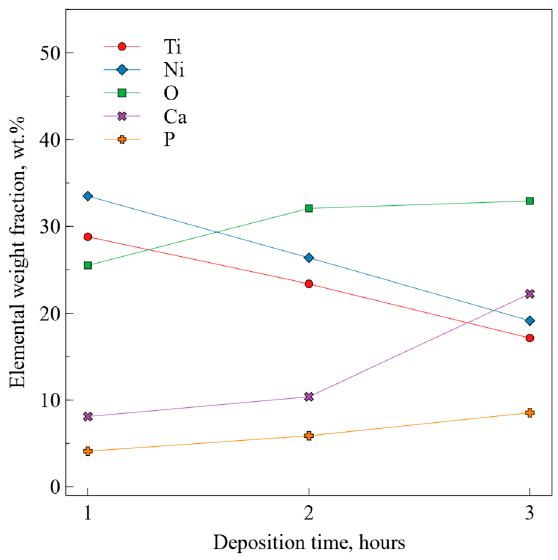
Figure 4. ( a ) SEM image of the NiTi with hydroxyapatite coating deposited for 3 h and elemental maps of: ( b ) Ti; ( c ) Ni; ( d ) Ca; ( e ) P; and ( f ) O.